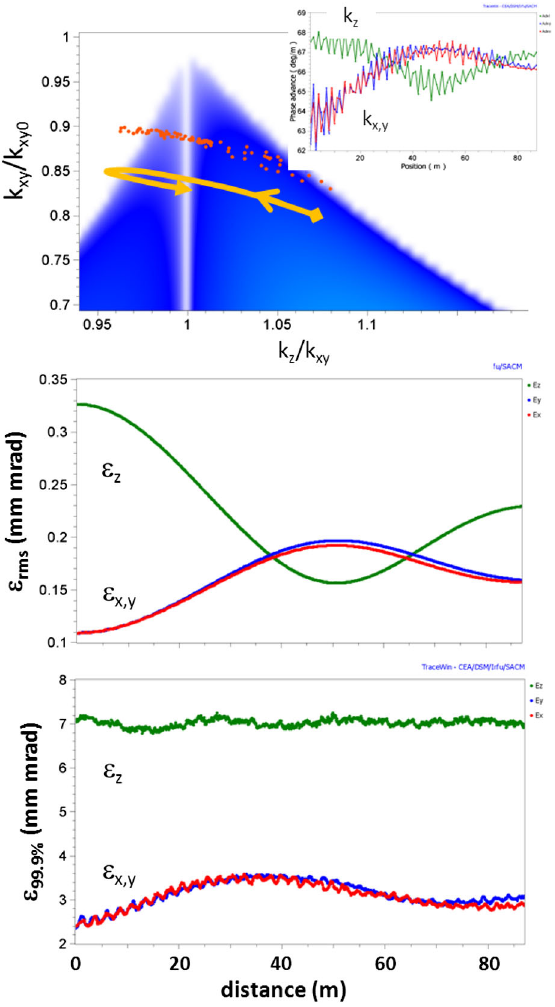
FIG. 8. Self-consistent evolution with k xy 0 ¼ 70 (cid:2) : tune foot- print on stability chart for (cid:2) z =(cid:2) x ¼ 3 (top, with graphs for k z and k x;y in the upper left corner); rms (center); and 99.9% (bottom)